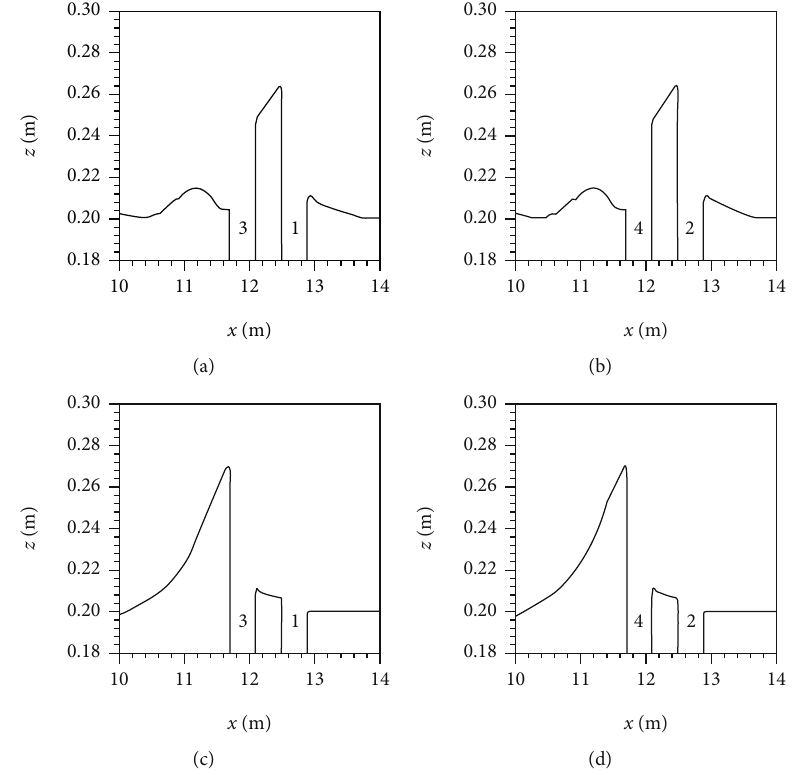
Figure 6: The maximum solitary wave run-ups at each cylinder for the square arrangement; (a) cylinder 1; (b) cylinder 2; (c) cylinder 3; (d) cylinder 4.